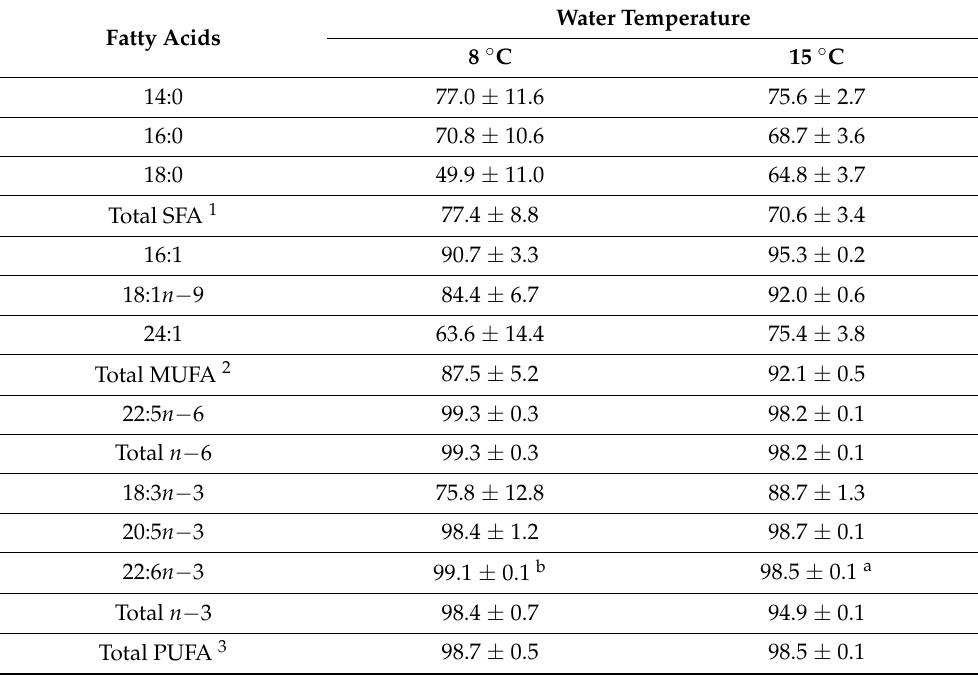
Table 5. Apparent digestibility coefficients (%, mean ± standard error, n = 3) of the fatty acids in rainbow trout fed Schizochytrium spp. when replacing 30% of a reference diet at two water temperatures, 8 ◦ C and 15 ◦ C. Fatty